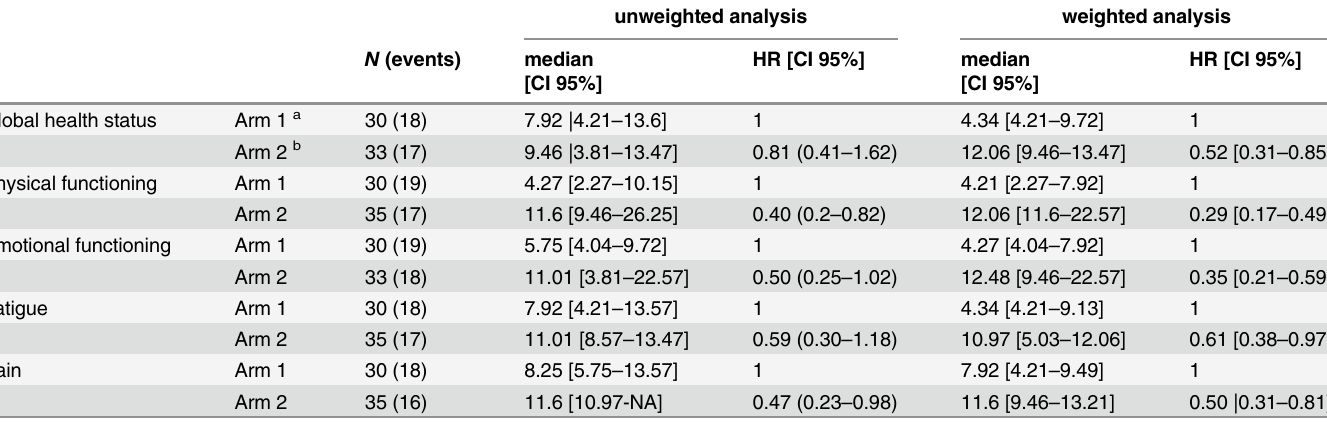
Table 4. Results of the Kaplan-Meier estimation of the health-related quality of life deterioration-free survival for a QLQ-C30 score and comparison between treatment